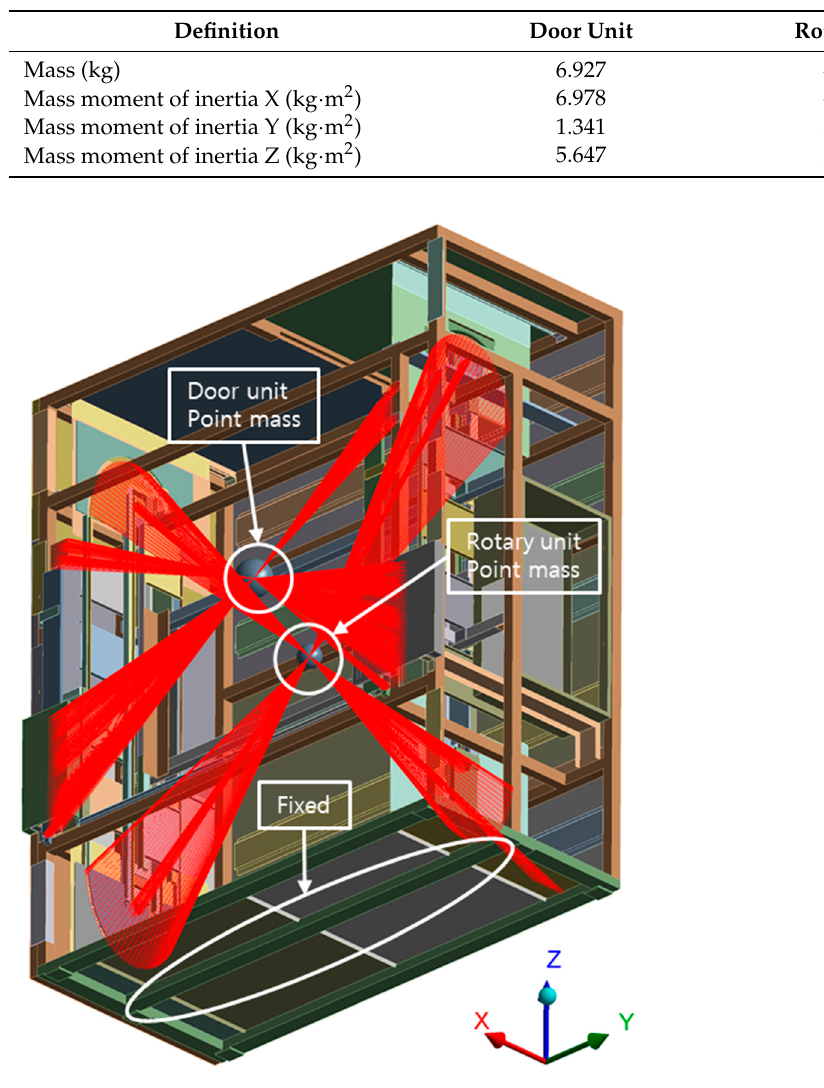
Figure 4. Boundary Conditions. Table 2. Point